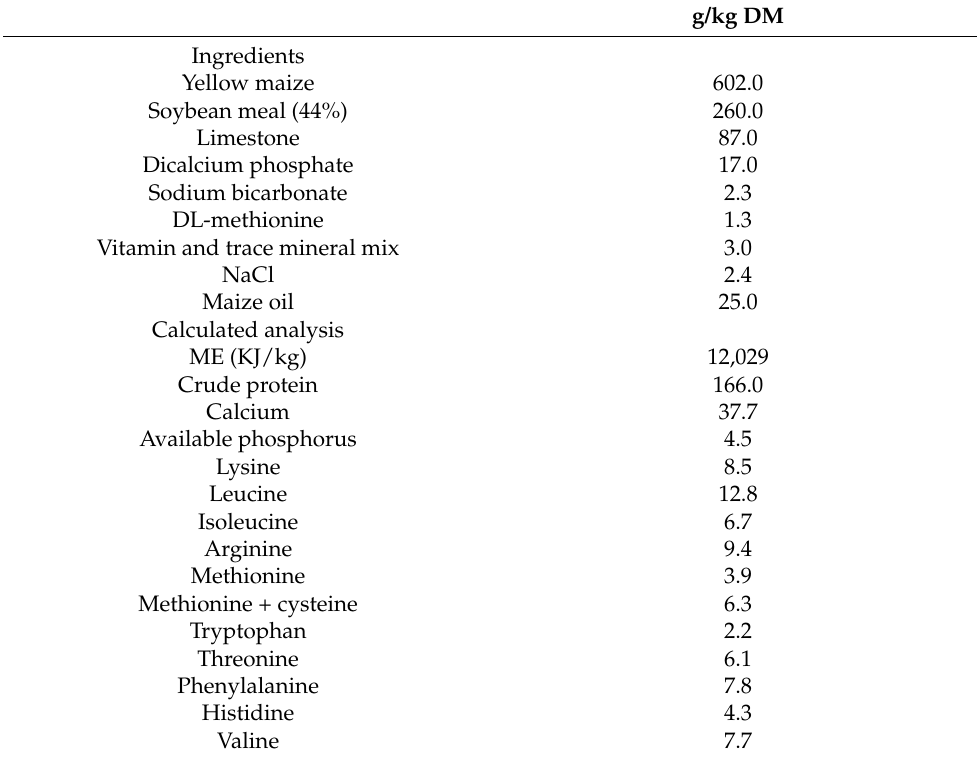
Table 1. Ingredients, composition, and calculated chemical analysis of the basal